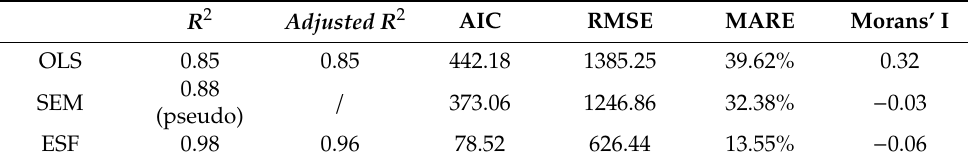
Table A7. Model performance of vcmsl version NTL data in 2017.